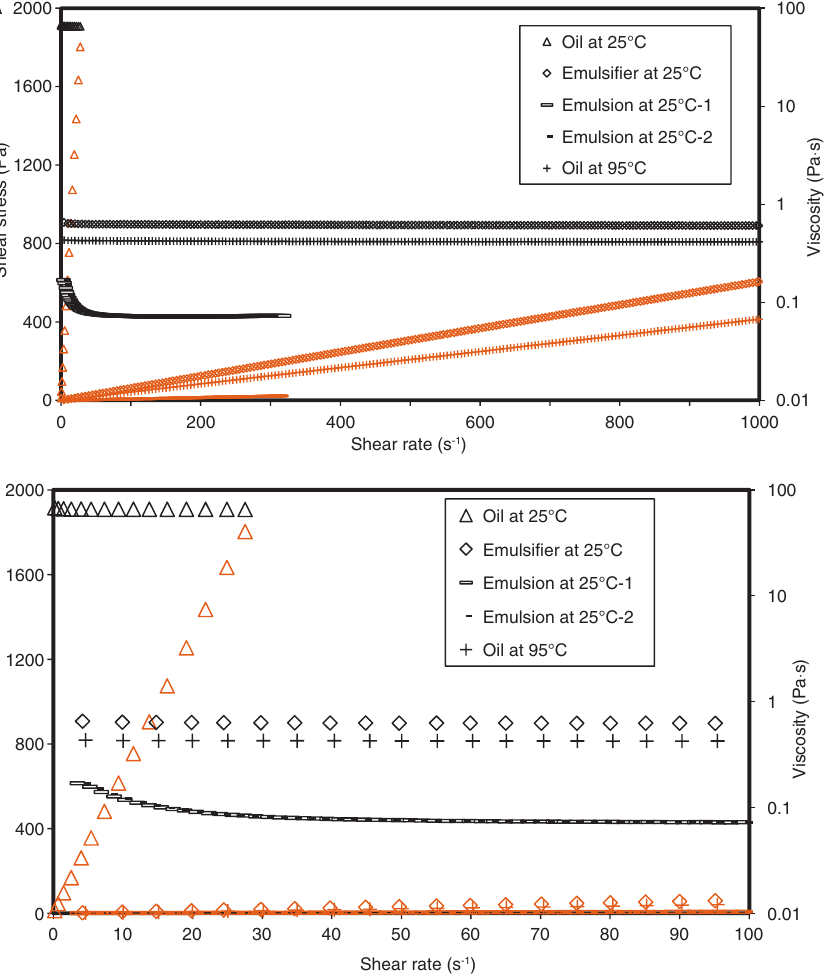
Figure 1 (A) Flow curves of Oil, emulsifier and emulsions (orange legends for shear stress and black legends for viscosity). (B) Flow curves magnification of Figure 1A (orange legends for shear stress and black legends for